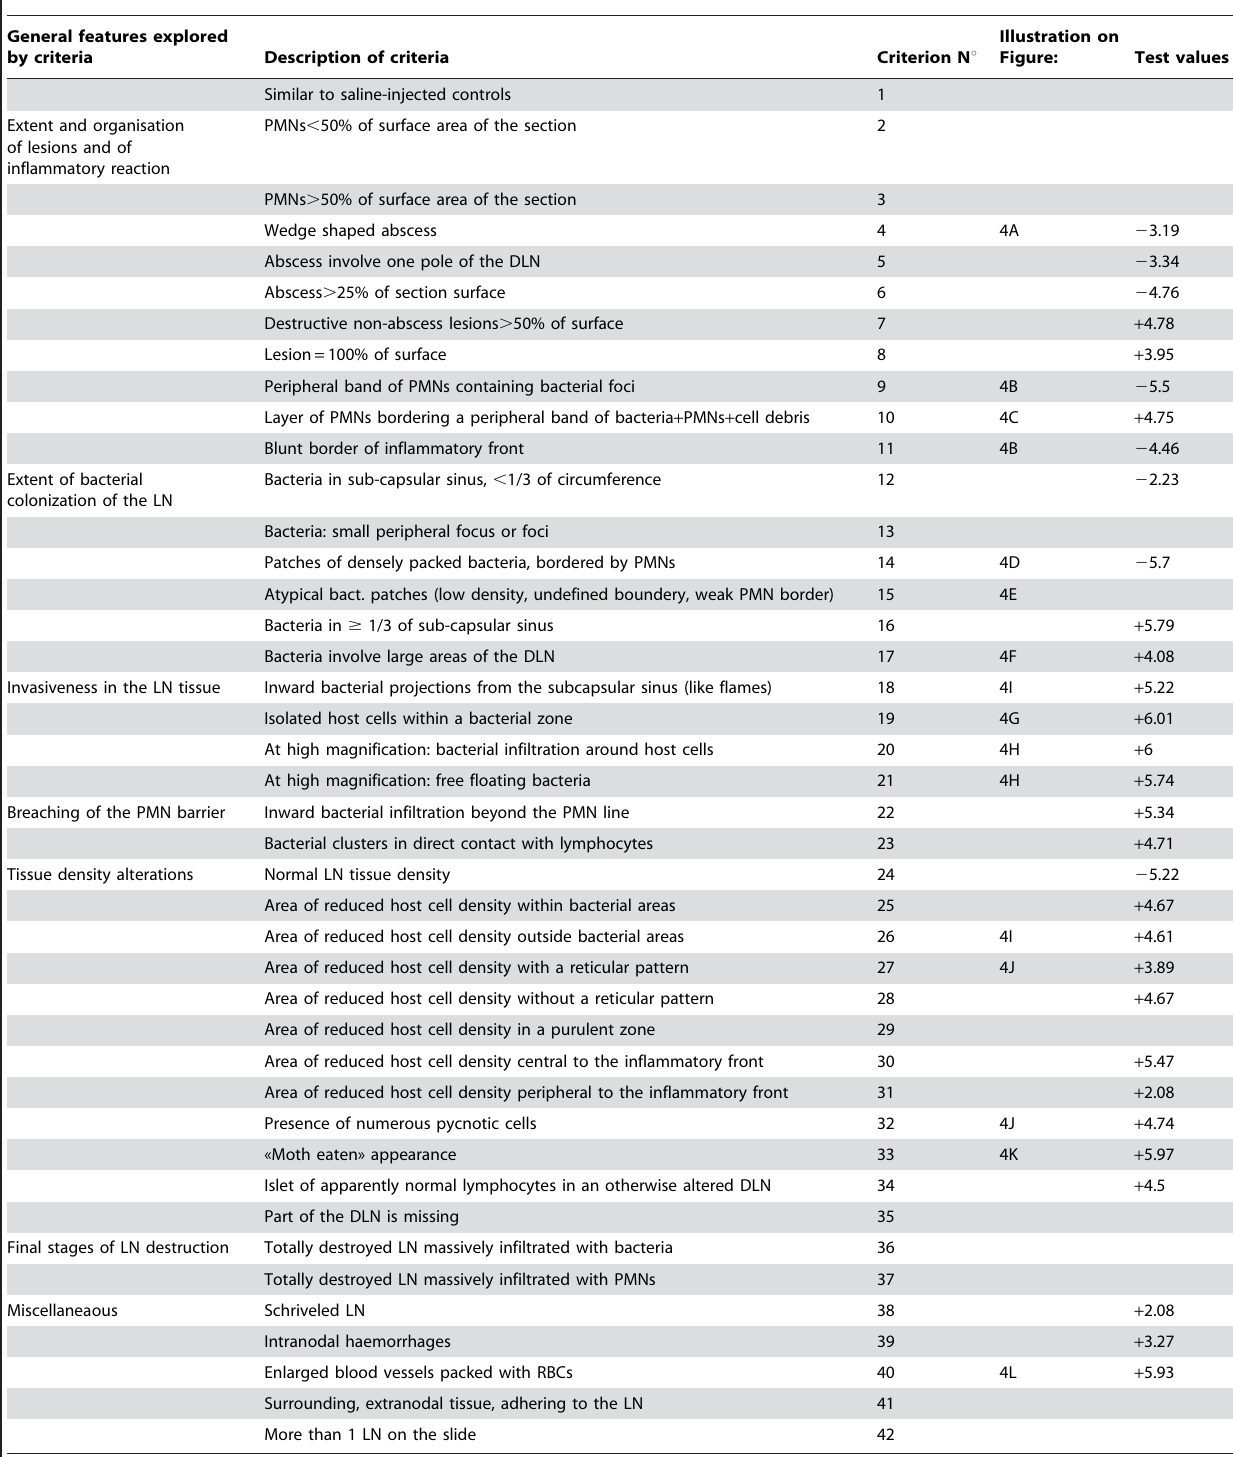
Table 1. Criteria used to score sections of lymph nodes infected with Y. pestis or Y. pseudotuberculosis , and their discriminating